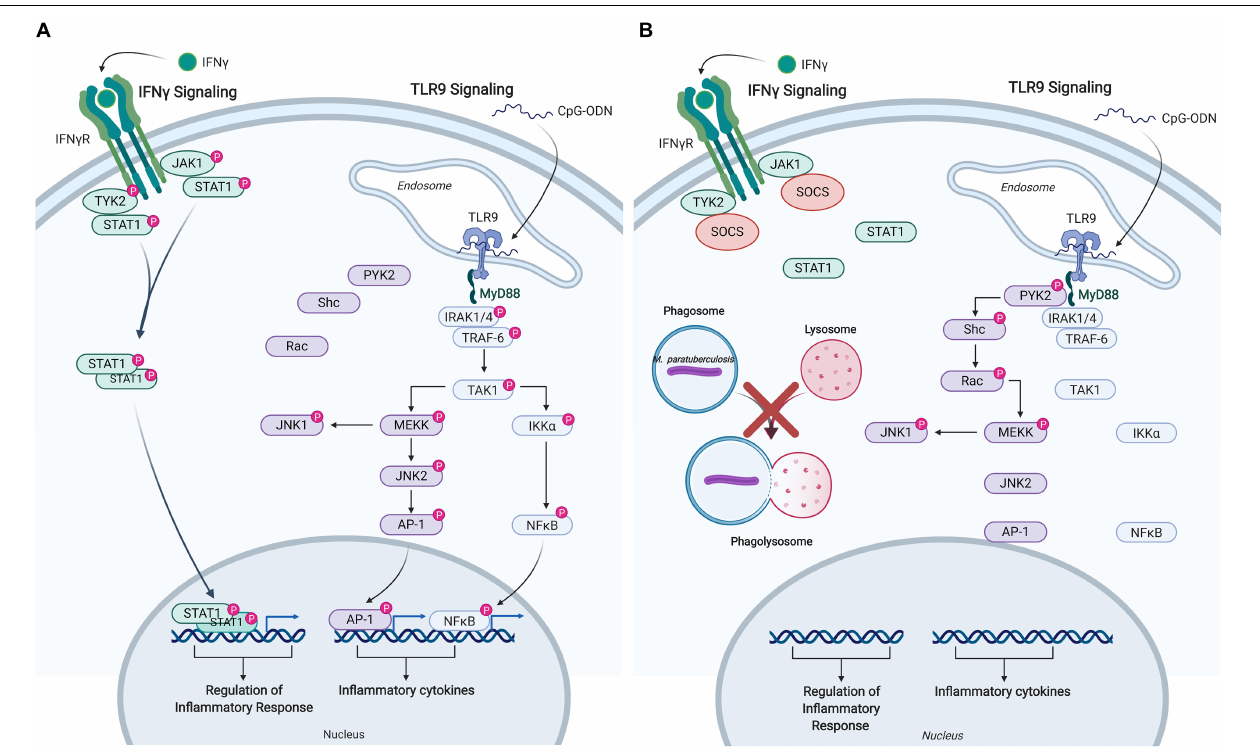
FIGURE 4 | Immune signaling pathways in bovine monocytes. Schematic representation of the IFN γ and TLR9 signaling pathways in response to exogenous stimuli and M. avium subsp. paratuberculosis infection. (A) Signaling pathways activated in uninfected bovine monocyte following stimulation with IFN γ , and TLR9 agonist CpG-ODN. Both pathways lead to the downstream phosphorylation of unique intermediates terminating with the translocation of distinct transcriptional activators into the nucleus to induce the expression of pro-inflammatory responses and cytokines. (B) M. paratuberculosis infection of bovine monocytes interferes with IFN γ signaling near the receptor by inducing the expression of SOCS, which disrupts JAK-STAT signaling. M. paratuberculosis infection also dysregulates TLR9 signaling by shunting the response toward the PYK2 pathway effectively blocking the induction of pro-inflammatory responses via MYD88. “P” designates protein in its phosphorylated state. Figure is adapted from Arsenault et al. (57, 58) and generated using BioRender. AP-1, adaptor protein complex 1; CpG-ODN, cytosine triphosphate-guanine triphosphate oligodeoxynucleotide; IFN, interferon; IKK α , inhibitor of nuclear factor kappa-B kinase subunit alpha; IRAK,